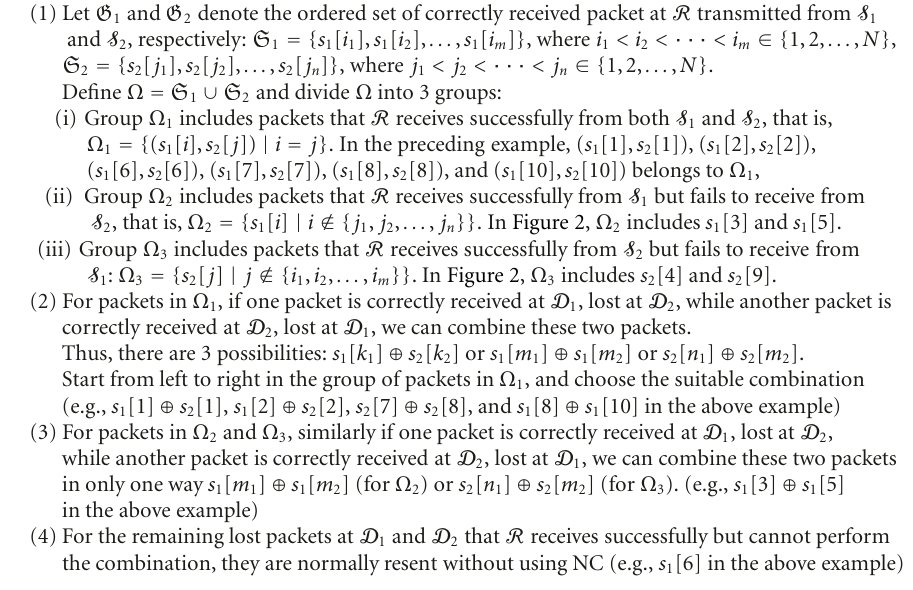
Algorithm 1: Algorithm at relay to retransmit Type-I packets.